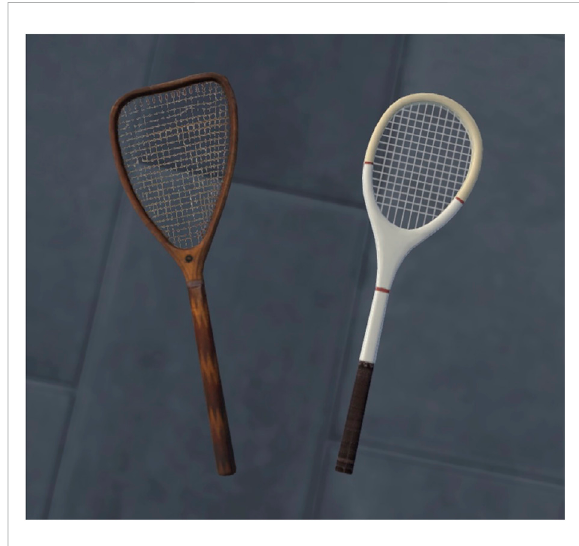
FIGURE 9 The two 3D models of real tennis rackets, 17th century racket on the left, contemporary racket on the right.